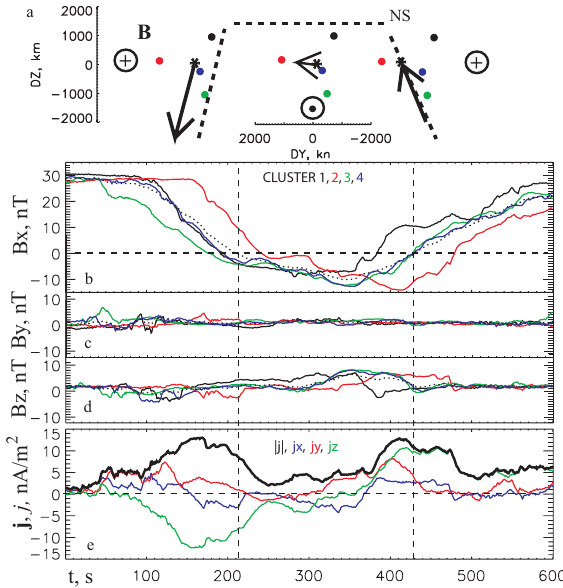
Fig. 6. Same as in Fig. 5 for class II current sheets.